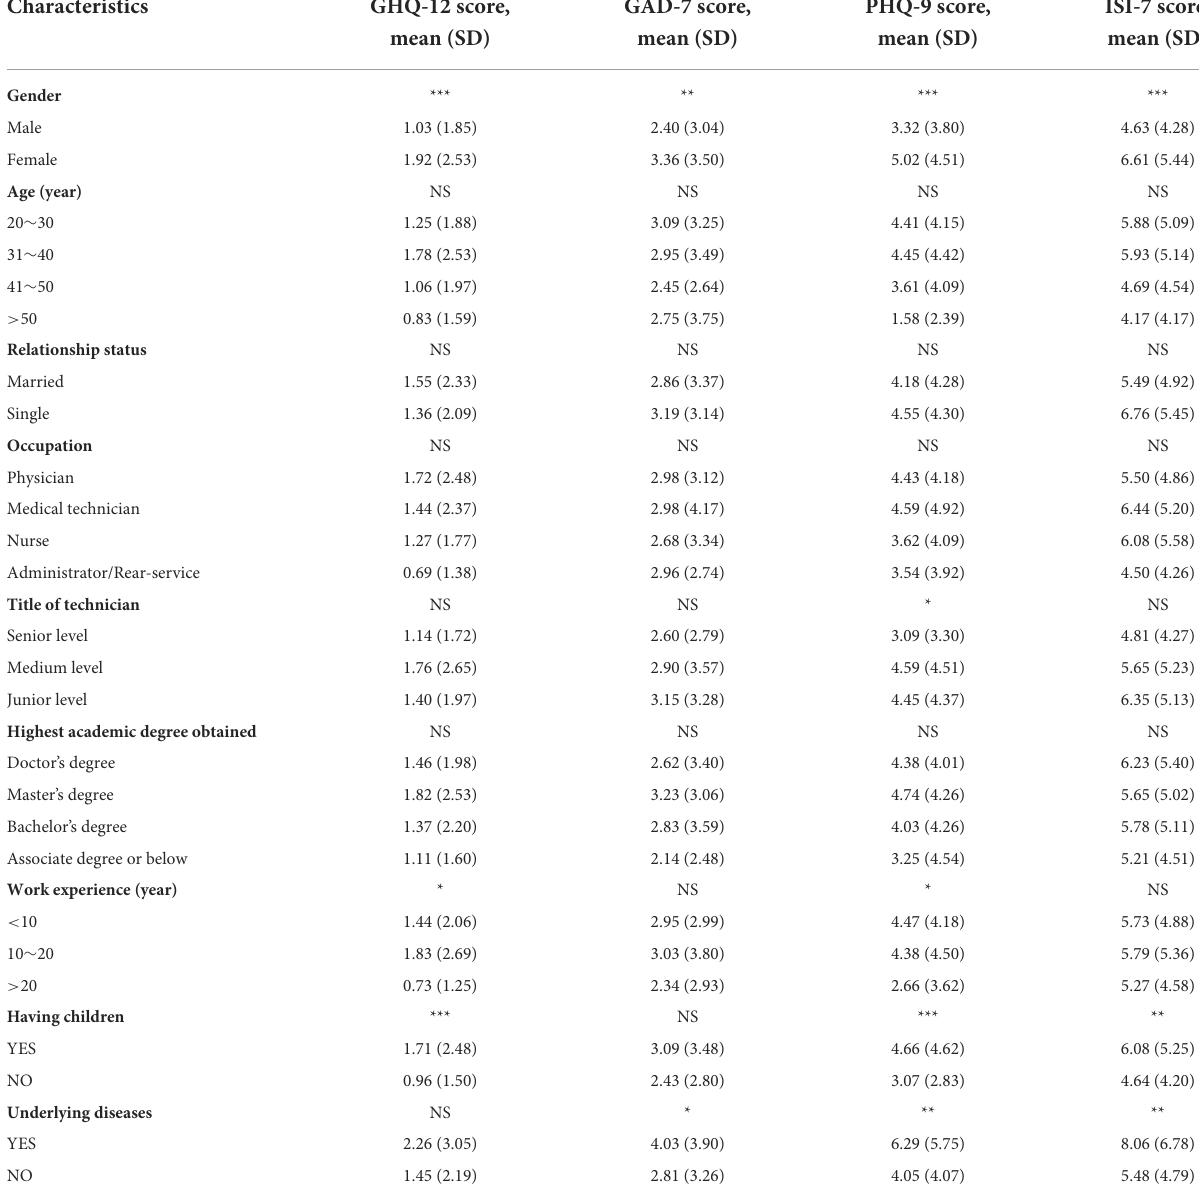
TABLE 2 Association of GHQ-12, GAD-7, PHQ-9 and ISI-7 scores with demographic characteristics ( n = 388). Characteristics GHQ-12